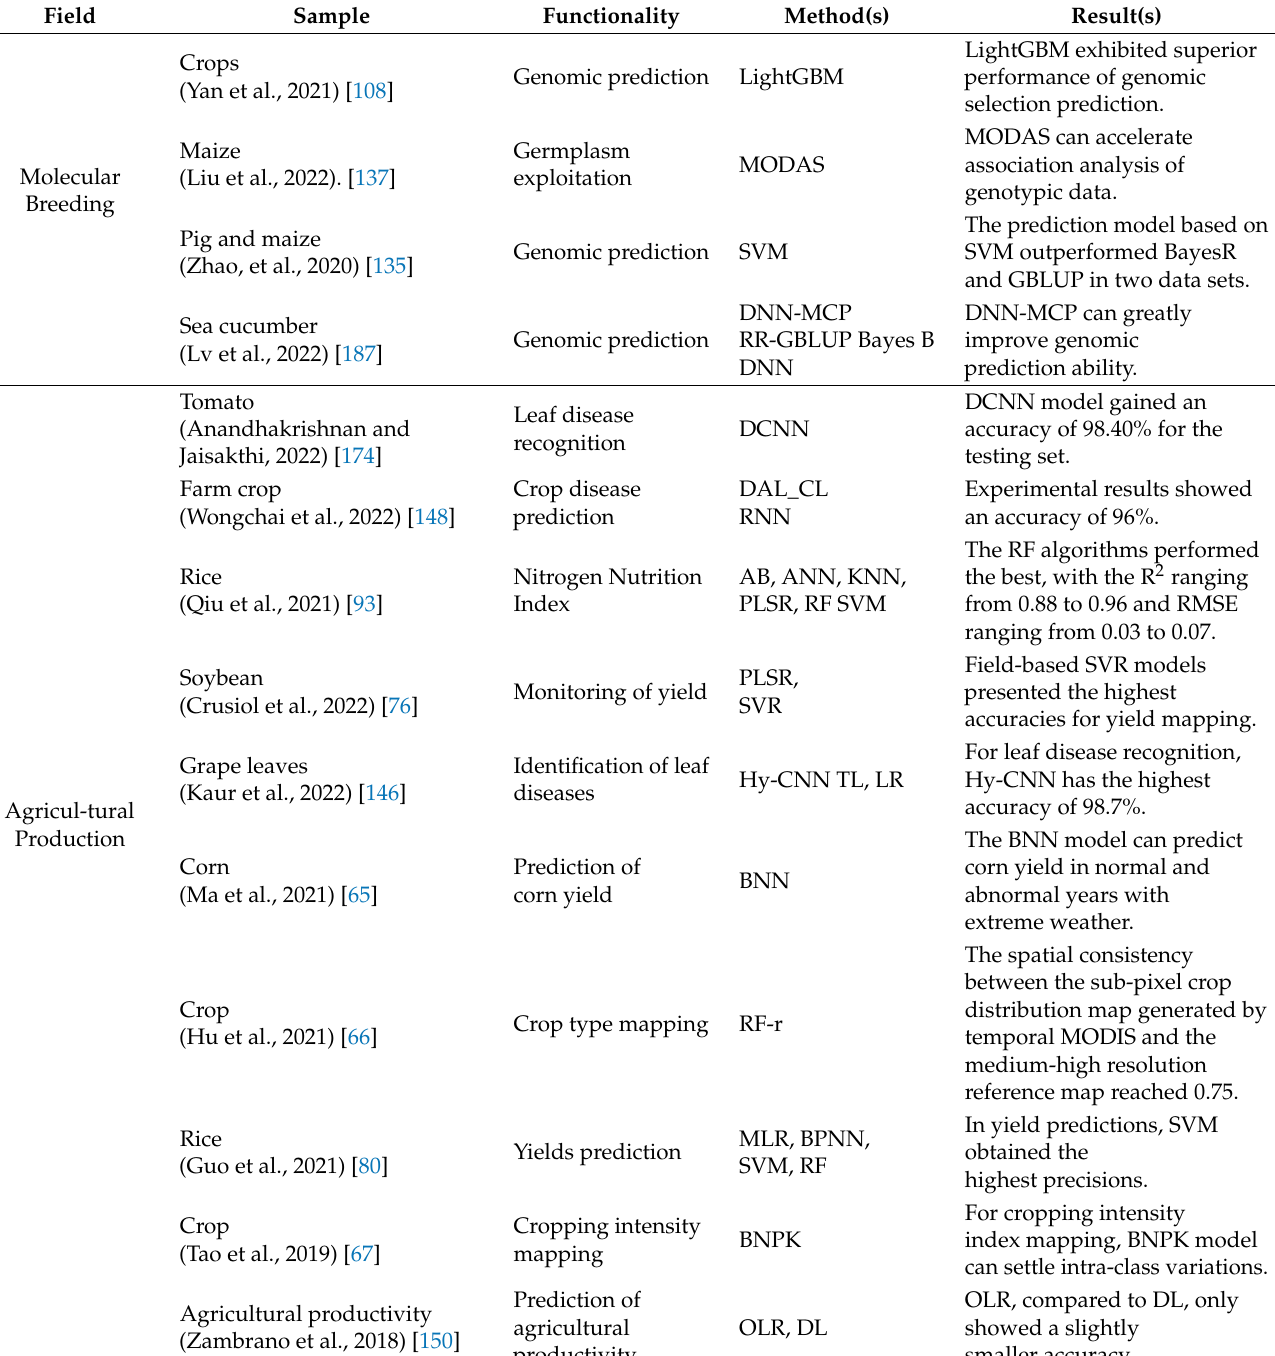
Table 2. AI technologies and